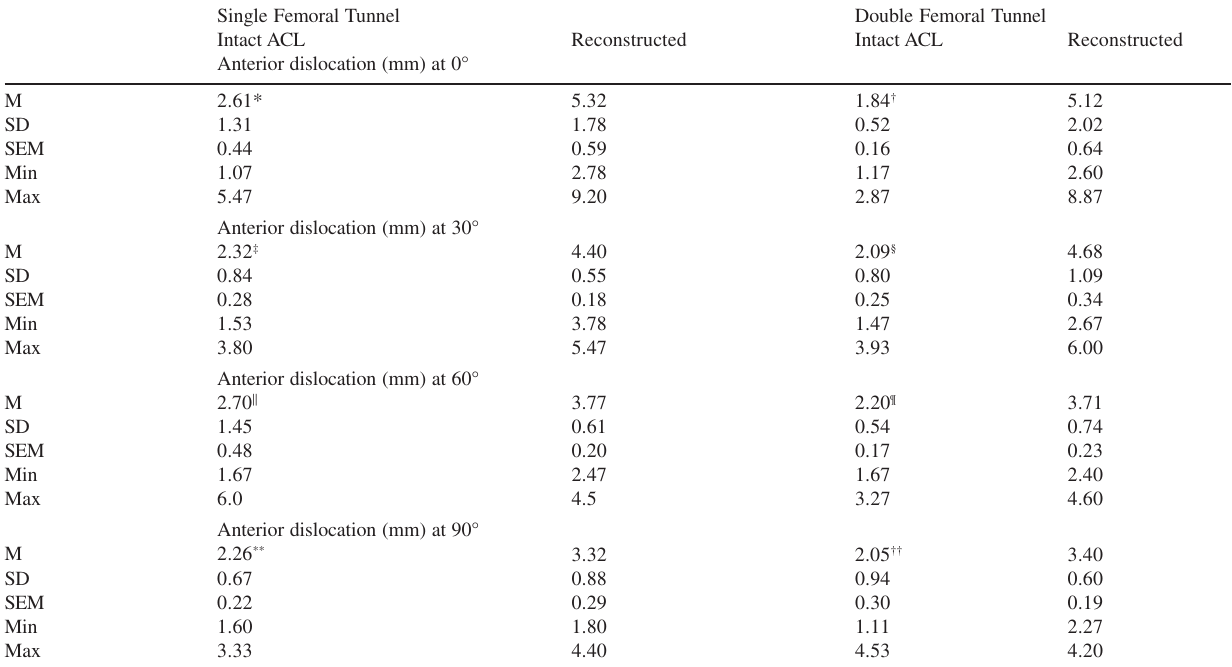
Table 1 - Anterior dislocation at 0°, 30°, 60°, and 90° flexion in knees subjected to reconstruction with single and double femoral tunnels preceded by their respective controls with intact anterior cruciate ligament (ACL) Single Femoral Tunnel